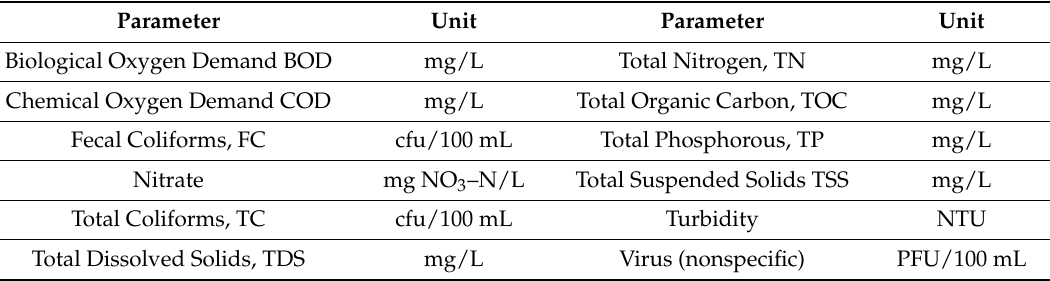
Table 4. Water quality parameters included in the